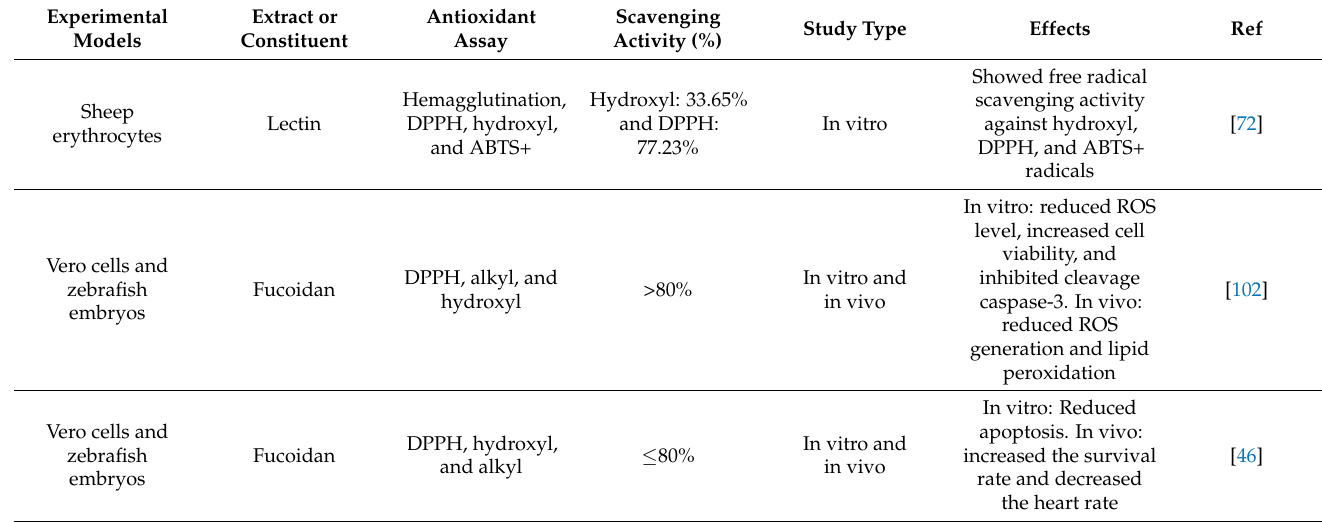
Table 6. Summary of the antioxidant activity of H. fusiformis